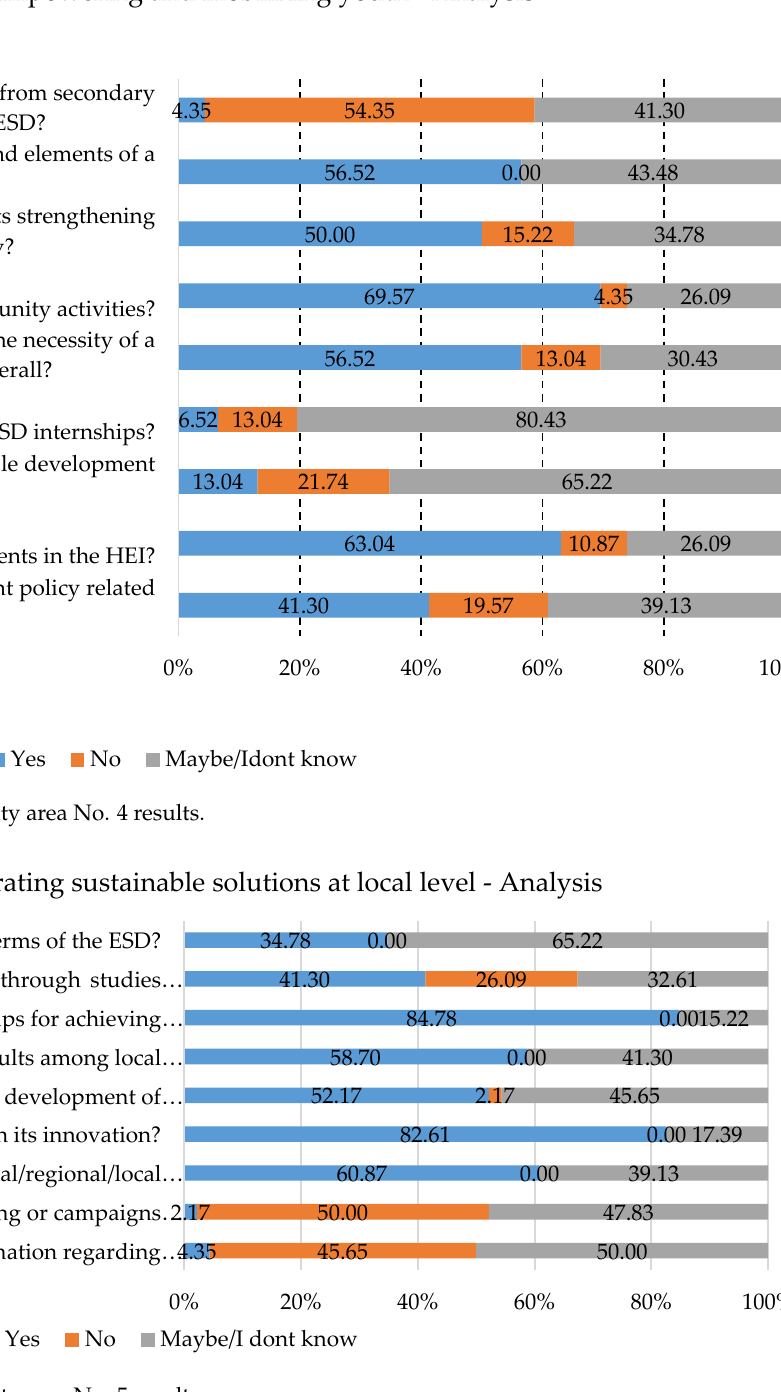
Figure 7. Priority area no.5 results.